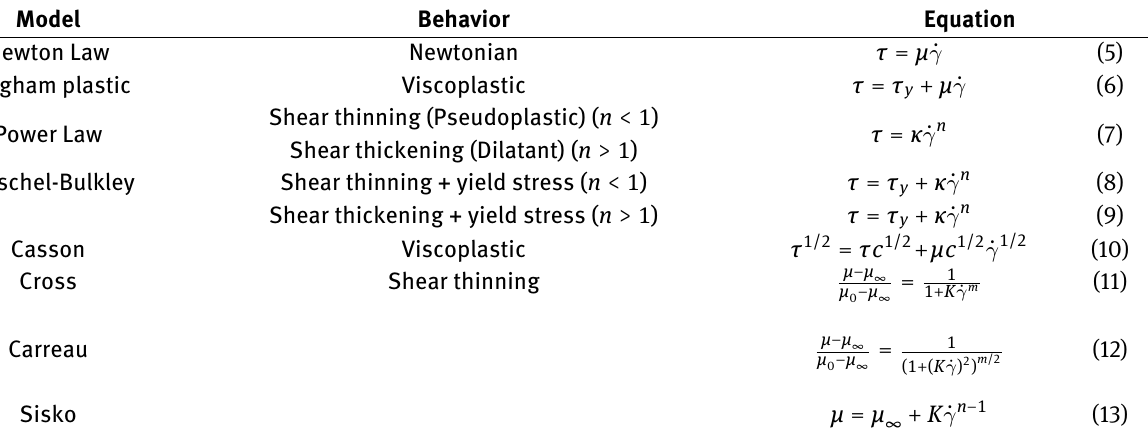
Table 1: Rheological models and state equations